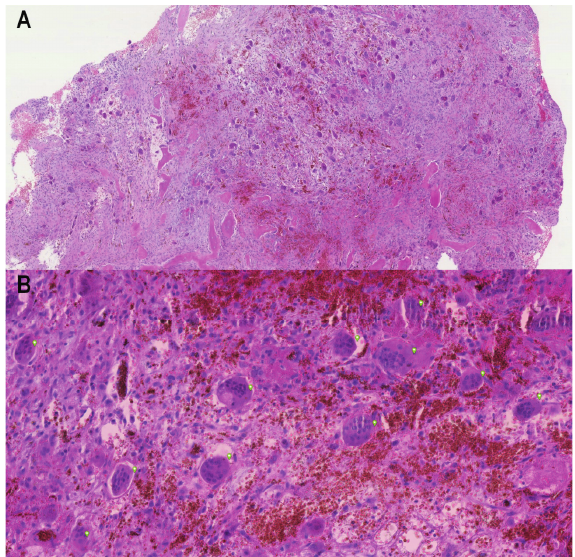
Figure 3: Brown tumor, located at Th12. (a) H&E, x5 histologic features of a giant cell reparative granuloma, in which stromal cells are admixed with osteoclastic giant cells, bone, and areas with hemorrhage. A zonal pattern is seen. Clusters of giant cells aggregate around red blood cells. The giant cells are surrounded by a zone of reactive fibrosis which, in turn, is bounded by the reactive bone. (b) H&E, x100 stromal cells admixed with osteoclast-like giant cells. The multinucleated giant cells, indicated by green dots, aggregate around red blood